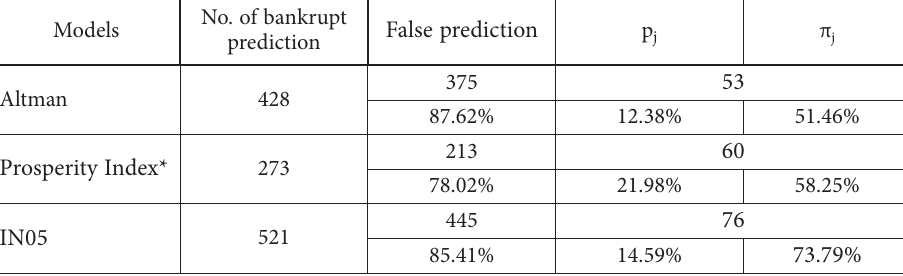
Table 4. Validation of Models – Results (source: Delina & Packová, 2013)